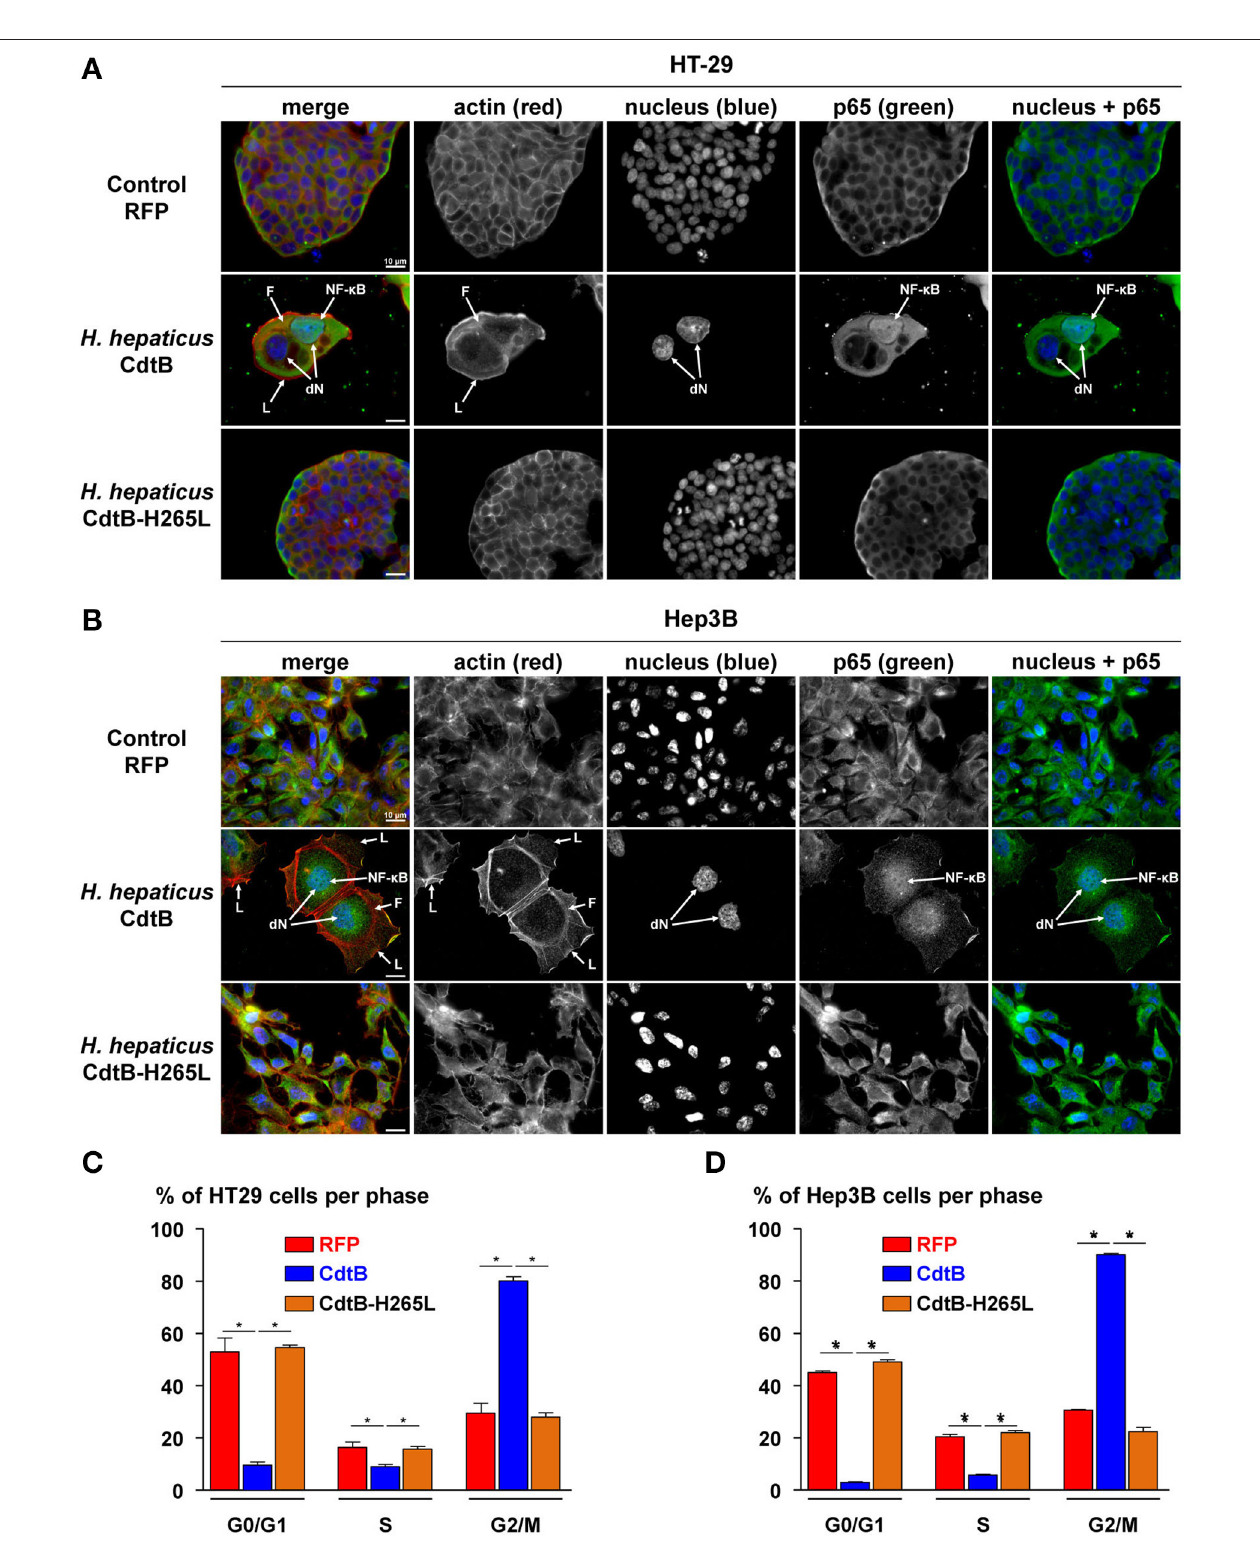
FIGURE 1 | Effects of the CdtB subunit of Helicobacter hepaticus CDT on the cytoskeleton and cell cycle of intestinal and hepatic epithelial cell lines. Intestinal HT-29 and hepatic Hep3B transgenic cells were cultivated with doxycycline for 72 h to induce the expression of the control Red Fluorescent Protein (RFP), the CdtB of